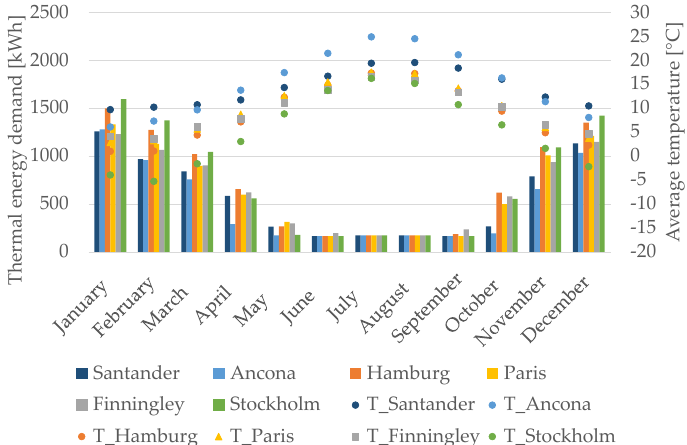
Figure 6. Monthly thermal energy demand (left axis) for a single dwelling in the different cities, whose average monthly temperature is reported on the right axis.